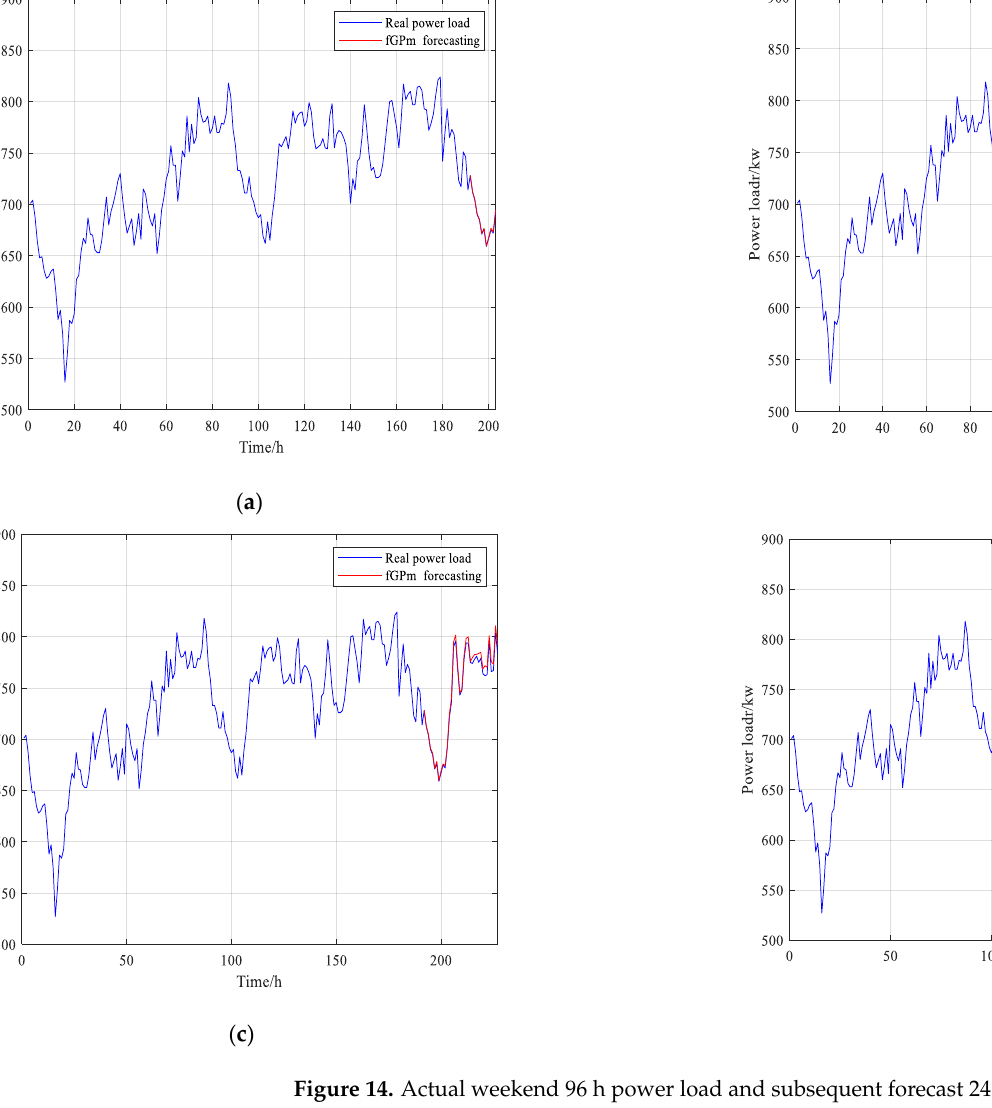
Figure 14. Actual weekend 96 h power load and subsequent forecast 24 h trend chart. ( a ) 6 h ( b ) 12